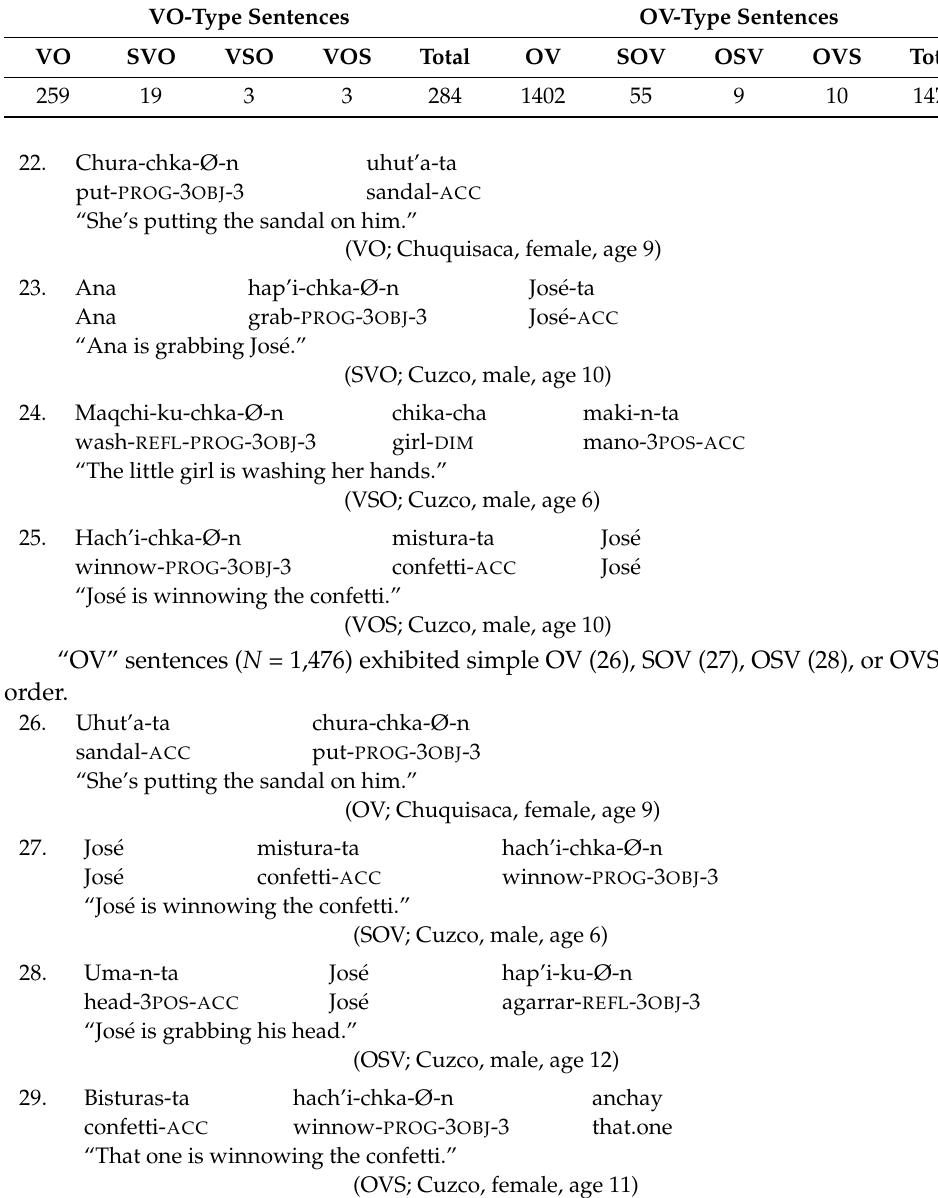
Table 4. Frequency of VO- and OV-type